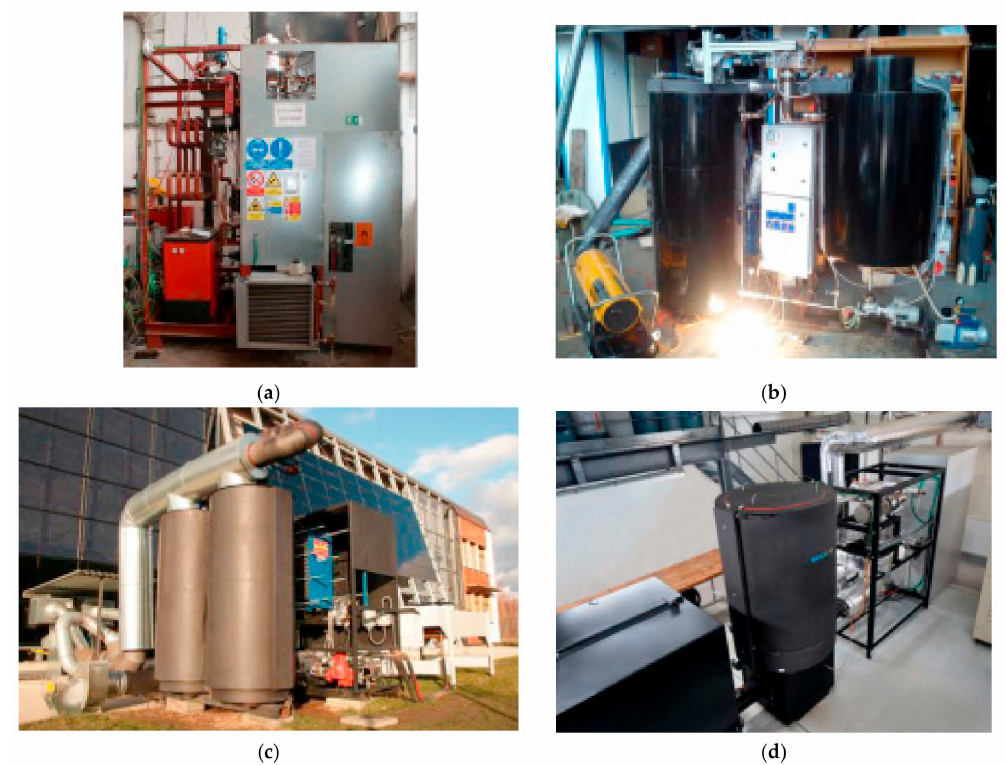
Figure 9. The general views of the ORC test stands implemented at the Czech Technical University in Prague [69]. ( a ) First experimental ORC unit; ( b ) Second experimental ORC unit; ( c ) WHR (Waste Heat Recovery) demonstration unit; ( d ) combined heat and power (CHP) biomass-fired 3.5-kW ORC unit. Reproduced with permission from Vaclav Novotny, Energy Procedia; published by Elsevier,